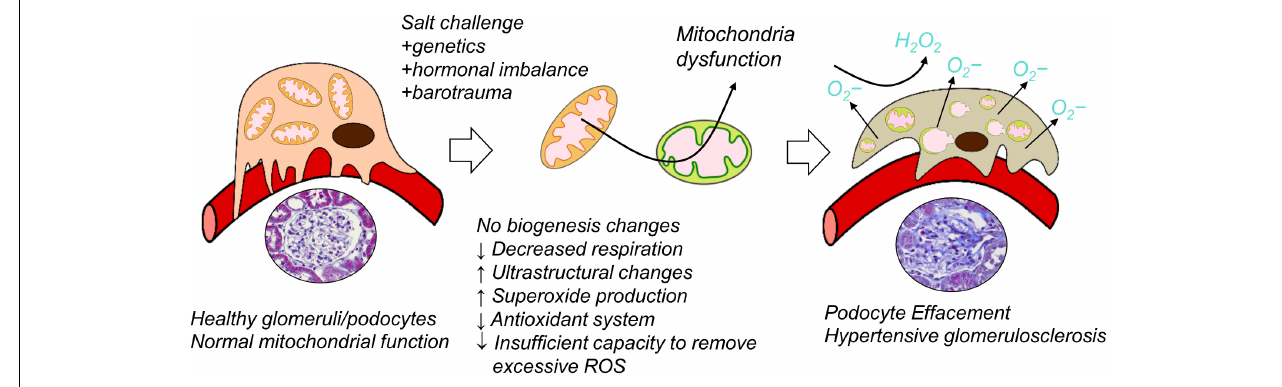
FIGURE 6 | Suggested schematic illustration of the contribution of renal mitochondrial dysfunction to glomerular damage occurring in salt-sensitive (SS)